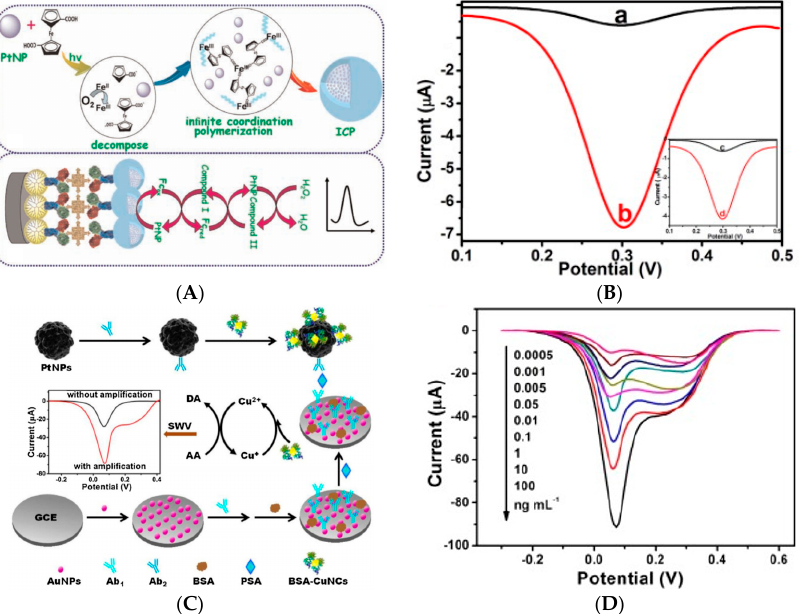
Figure 25. ( A ) ( a ) Formation of ‘all-in-one’ redox-active PtNP@ICP catalyst; and ( b ) coupling this ‘all- ( A ) ( a ) Formation of ‘all-in-one’ redox-active PtNP@ICP catalyst; and in-one’ catalyst on Ab 2 and transduction for PSA detection; ( B ) DPV of PtNP@ICP-Ab 2 /PSA/Ab 1 - ( b ) coupling this ‘all-in-one’ catalyst on Ab 2 and transduction for PSA detection; ( B ) DPV PAMAM-GCE for various PSA concentration (a) 0 ng mL − 1 ; and (b) 5 ng mL − 1 [inset: DPV of ICP-Ab 2 / and (b) 5 ng mL − 1 [inset: DPV of ICP-Ab 2 / PSA/Ab 1 -PAMAM-GCE toward different